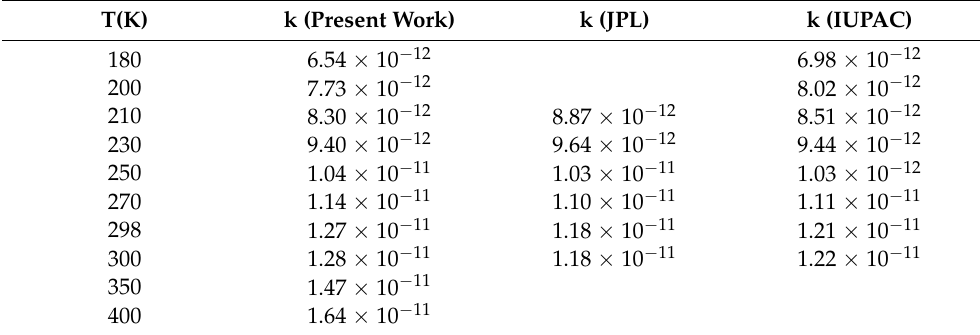
Figure 2. Arrhenius plot for the reaction of O 3 with Cl obtained at the MRCI + Q/aug-ano-pVTZ//MP2/aug-cc-pV(T + d)Z levels of theory using CVT/SCT rate coefficients in the temperature range of 180 and 400 K along with the recommended rate coefficients by NASA/JPL [13] and IUPAC [51]. Table 3. Rate coefficients (cm 3 molecule − 1 s − 1 ) for the reaction of O 3 with Cl at the MRCI + Q/aug-ano-pVTZ//MP2/aug-cc-pV(T + d)Z levels of theory using CVT/SCT rate coefficients along with the recommended rate coefficients by NASA/JPL [13] and IUPAC [51] for